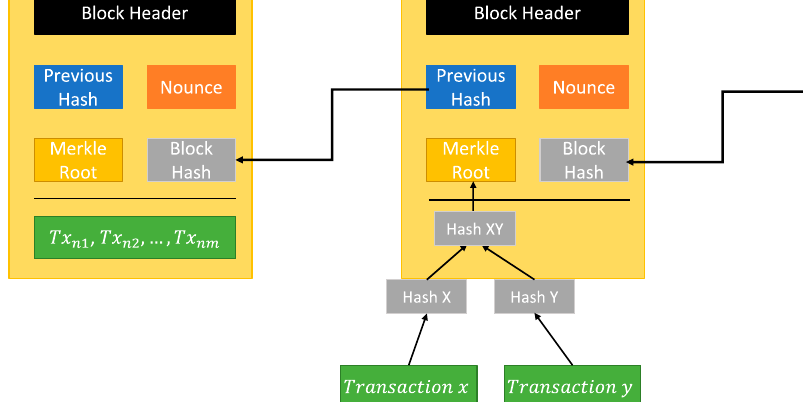
Figure 4. The Structure of a Block.